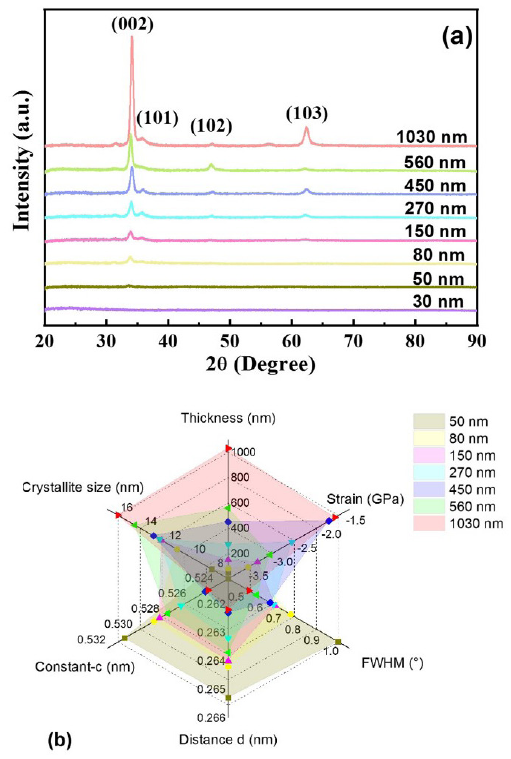
Figure 3. (a) Grazing incidence X-ray diffraction spectra of the AZO films deposited for different sputtering times. (b) Parameters extracted from the diffractogram together with the film thickness.